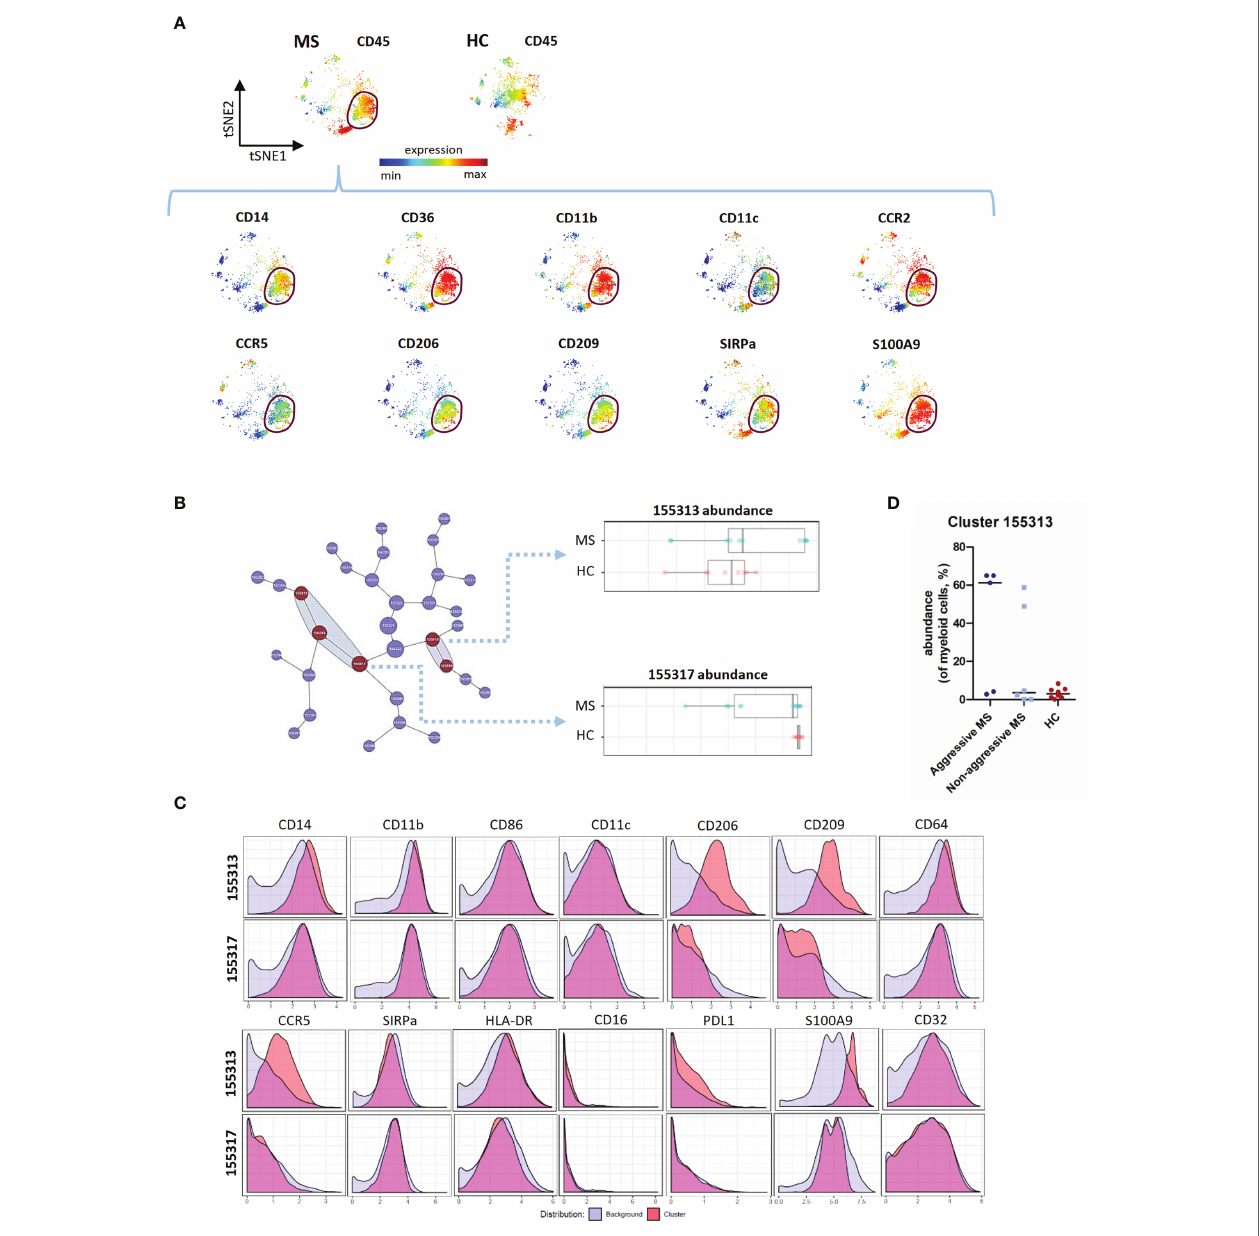
FIGURE 3 | CITRUS analysis of mass cytometry data from PBMC of MS patients and HC - Myeloid cell lineage. (A) Representative t-SNE maps, of a MS patient and a HC, regarding myeloid cells lineage. The t-SNE maps were generated based on expression levels of all markers of the myeloid panel ( Supplementary Table 2 ). Description of a myeloid subset in a MS patient (circled). Each dot represents one cell and the color spectrum represents individual marker-expression levels (red : high expression; blue : low expression). (B) Visual representation of unsupervised hierarchical clustering of myeloid cells and visualization of the clusters that are part of the signi fi cant results (in red). Abundance of the cluster 155313 and 155317 (of myeloid cells) in MS patients and HC. (C) Expression of CD14, CD11b, CD86, CD11c, CD206, CD209, CD64, CCR5, SIRPa, HLA-DR, CD16, PD-L1, S100A9 and CD32 measured on cells from cluster 155313 and 155317 as compared to all other (background) myeloid cells. (D) Abundance of cluster 155313 (of myeloid cells, %), in « aggressive MS » patients, « non aggressive MS » patients and